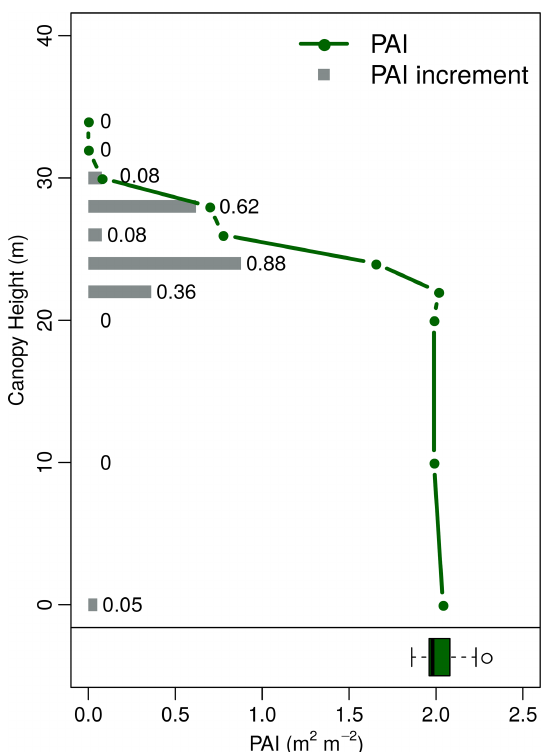
Figure A1. Profile of the plant area index (PAI) at the Speulderbos